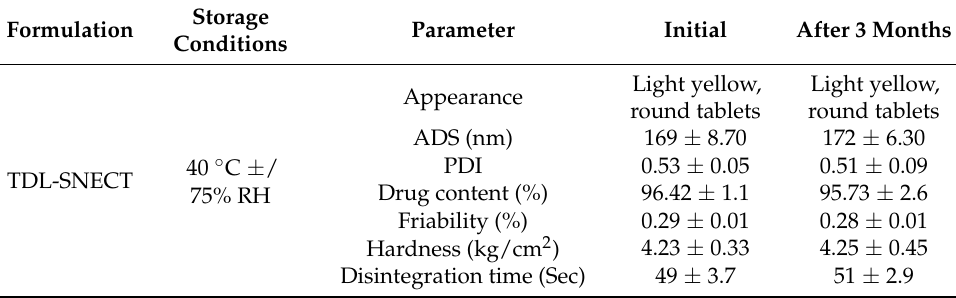
Table 8. Results of accelerated stability tests.